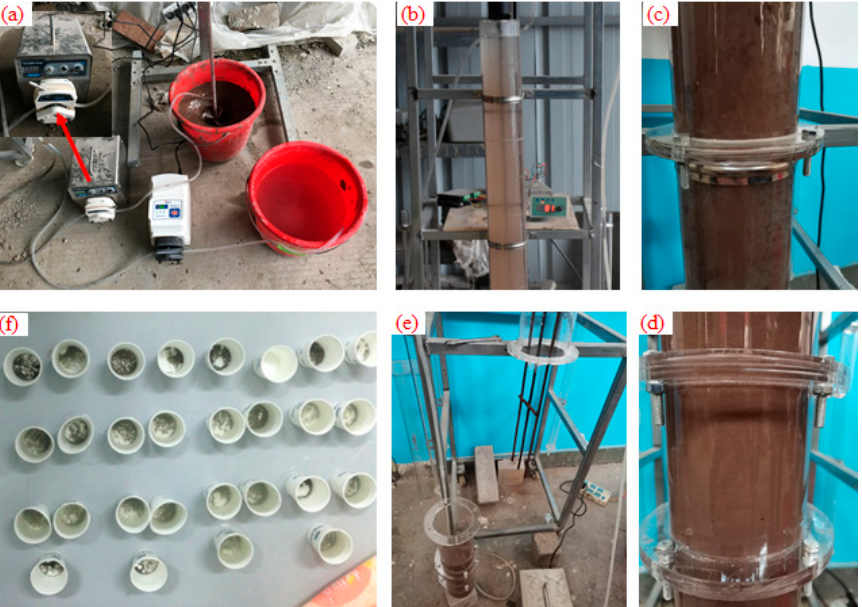
Figure 3. Experimental process of tailings flocculation concentration. ( a ) Tailing mortar mixing and parameter setting of a peristaltic pump. ( b ) Tailing mortar mixed with flocculant. ( c ) Flocculation settlement under shear conditions. ( d ) Flocculation settlement without shear. ( e ) Bottom bed floc density. ( f ) Bottom discharge concentration test.